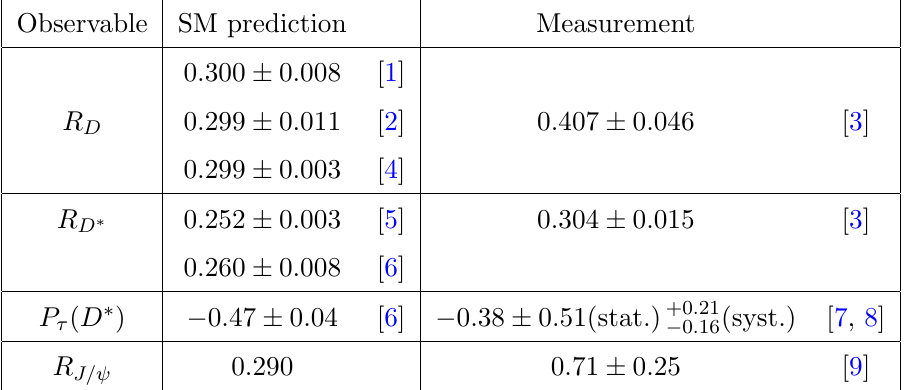
Table 1 . Observables, their SM predictions and the experimentally measured values. The exper- imental averages for R D and R D (cid:3) shown in the third column are based on [7, 10{15]. The SM prediction of R is based on the form-factors given in [16], see appendix B for more details. As J= the B c !